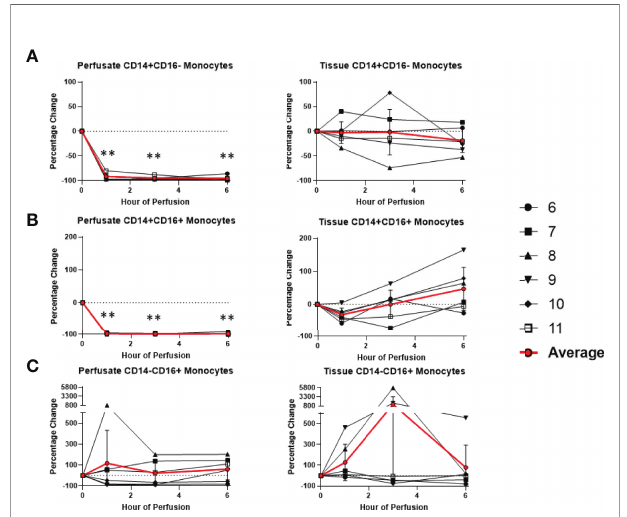
FIGURE 9 | Percentage change offrequency of cells from monocyte lineage during perfusion. A percentage change of 0% suggests there is no change in the innate immune cell frequency from time point 0 th hour. Average values of percentage changes (red line) as well as standard deviations were calculated (vertical bar). A two-sided, paired t-test was performed to compare percentages of each time point to those at time 0H. (** P<0.01). (A) Perfusate classical monocyte frequency decreased at the 1 st hour of perfusion (-91.6 ± 5.8%) and remained decreased at the 6 th hour of perfusion (-95.6 ± 4.3%), with no changes observed in tissue classical monocyte frequency. (B) Perfusate intermediate monocyte frequency decreased at the 1 st hour of perfusion (-98.3 ± 1.5%) and remained decreased at the 6 th hour of perfusion (-98.5 ± 2.7%), while tissue intermediate monocyte frequency decreased at the 1 st hour of perfusion (-53.2 ± 17.6%) and returned to baseline at the 3 rd hour of perfusion. (C) No changes were observed in perfusate non-classical monocyte frequency and tissue non-classical monocyte frequency.